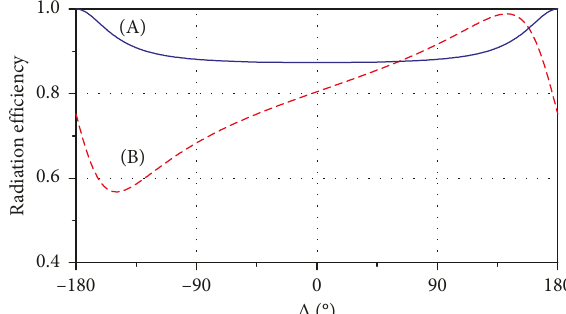
Figure 5: Dependences of the radiation efficiency from phase Δ for both arrays: (A) H-array; (B)